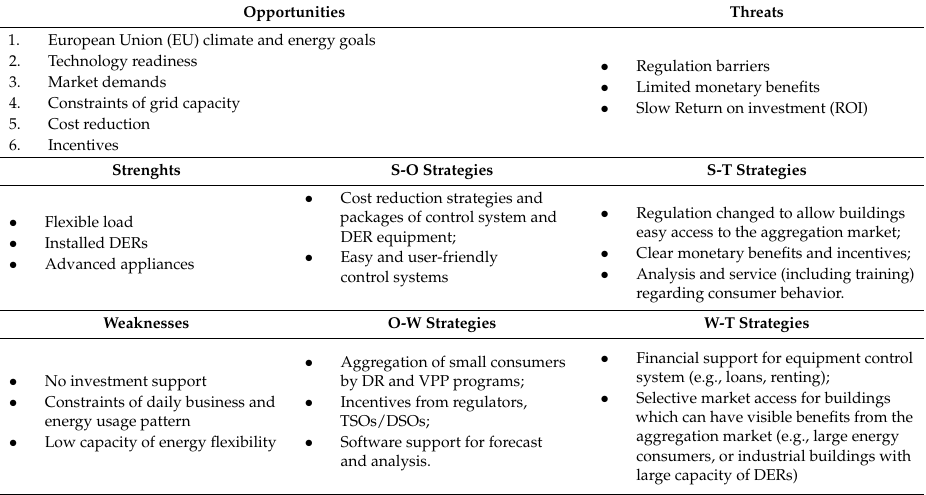
Table 12. Combined SWOT and TOWS analyses of buildings’ energy aggregation potentials. Opportunities